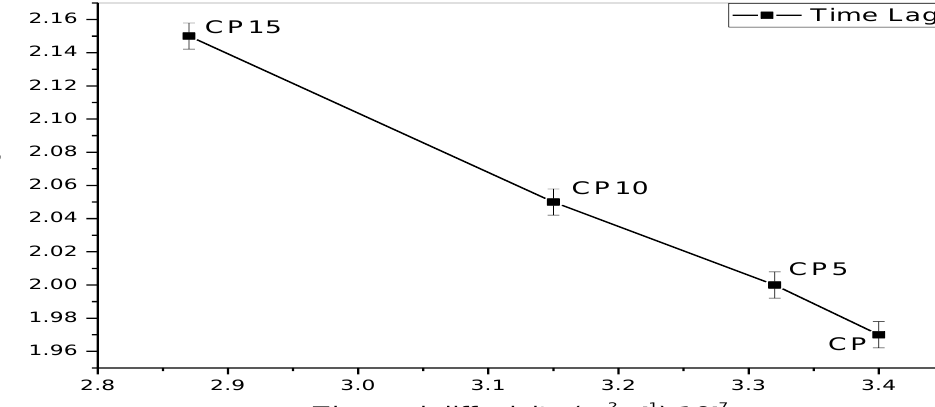
Figure 14. Time lag as function of Thermal energy.